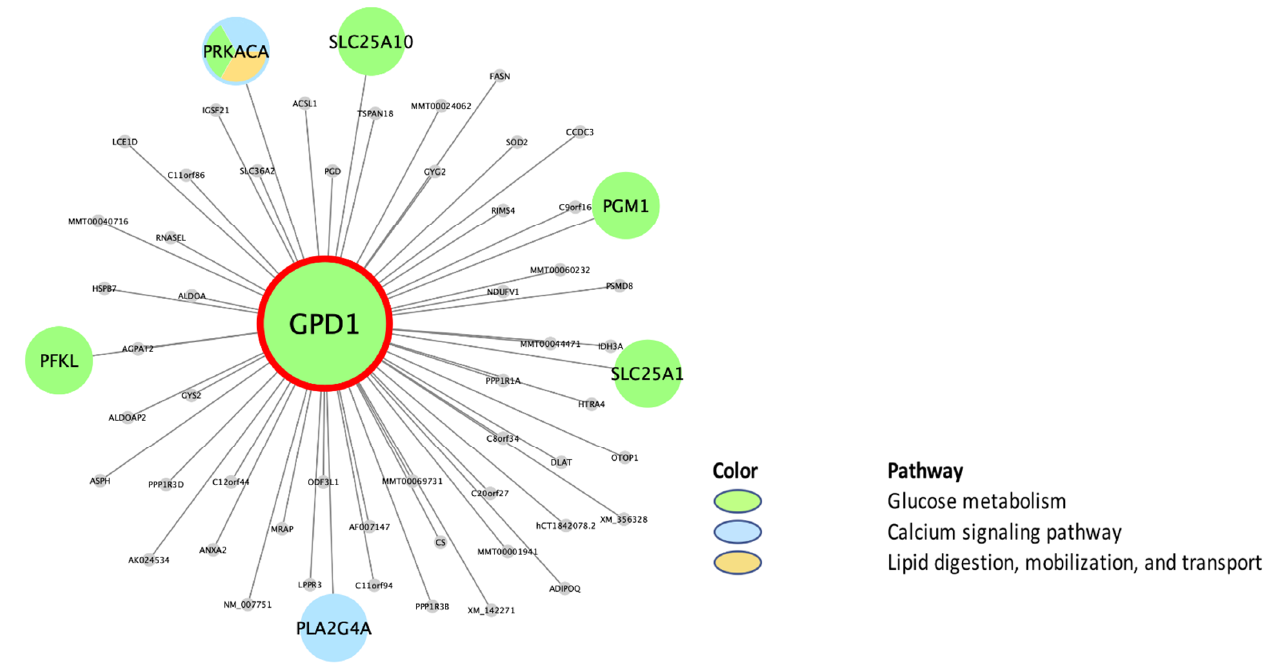
Figure 3. Adiposity-specific gene-regulatory networks of top KDs in meta-analysis of CRP and IL6. (CRP, C-reactive protein; eQTL, expression quantitative trait loci; IL6, interleukin-6; KD, key drivers. The bigger nodes with red outlines are the top KDs in the enriched pathway obtained from weighted KD analysis. The subnetworks of the KDs are indicated by different colors according to differences in their canonical functions.).